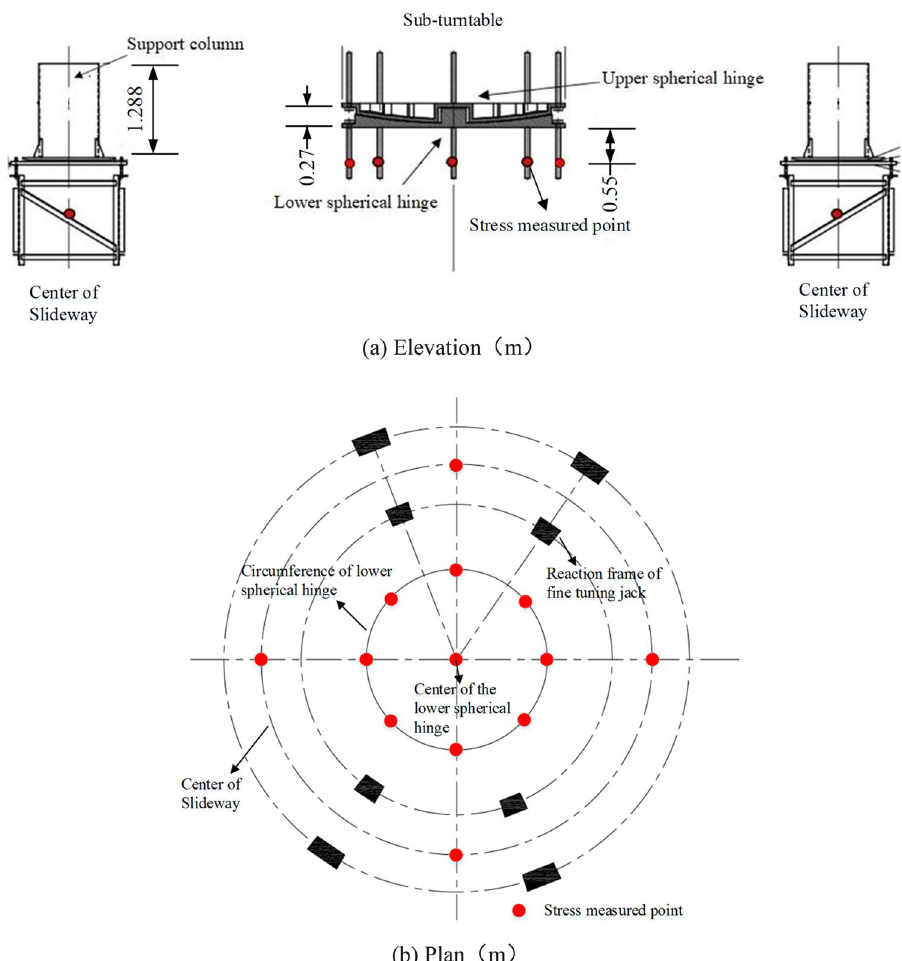
Figure 5. Stress measured point arrangement of sub-turntable.